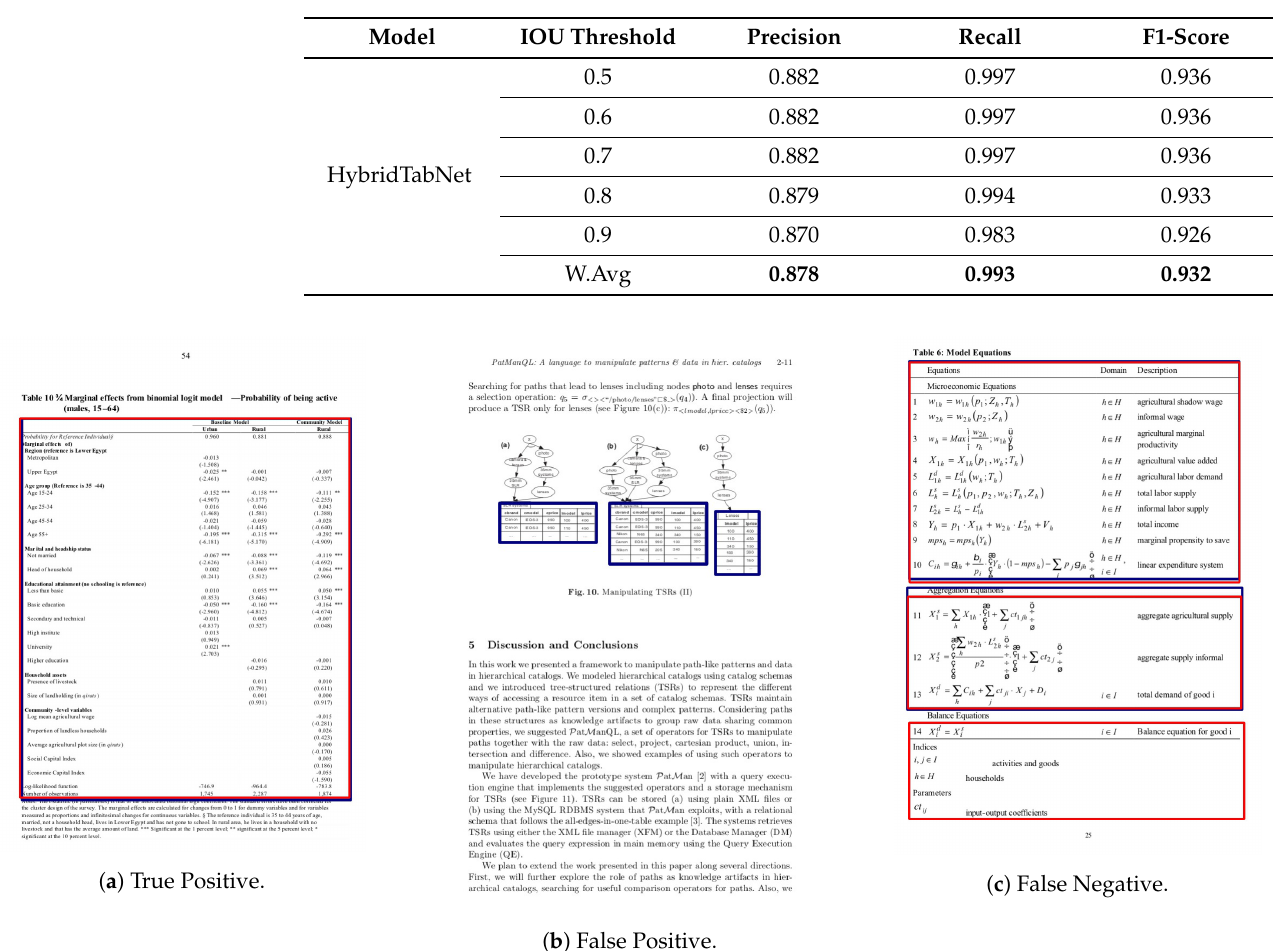
Figure 5. HybridTabNet results on the ICDAR-2017 dataset. ( a – c ) True positive, False positive, and False negative results, respectively. The blue outline shows the predicted table, and the red outline highlights the ground truth